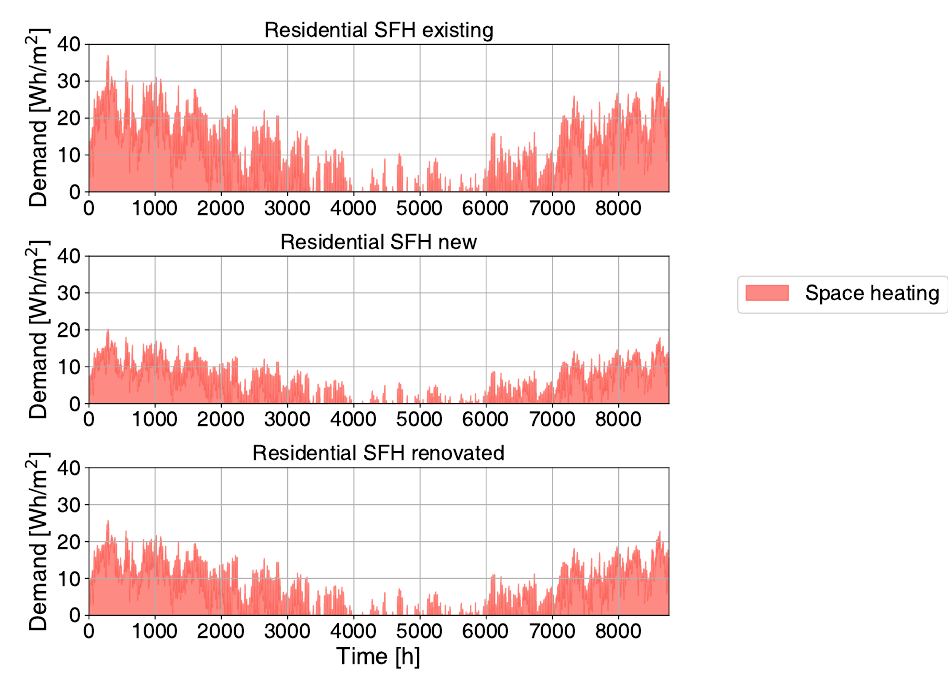
Figure A2. Hourly specific energy service demand of residential SFH buildings. Table A19. Yearly specific energy service demand of residential SFH buildings.